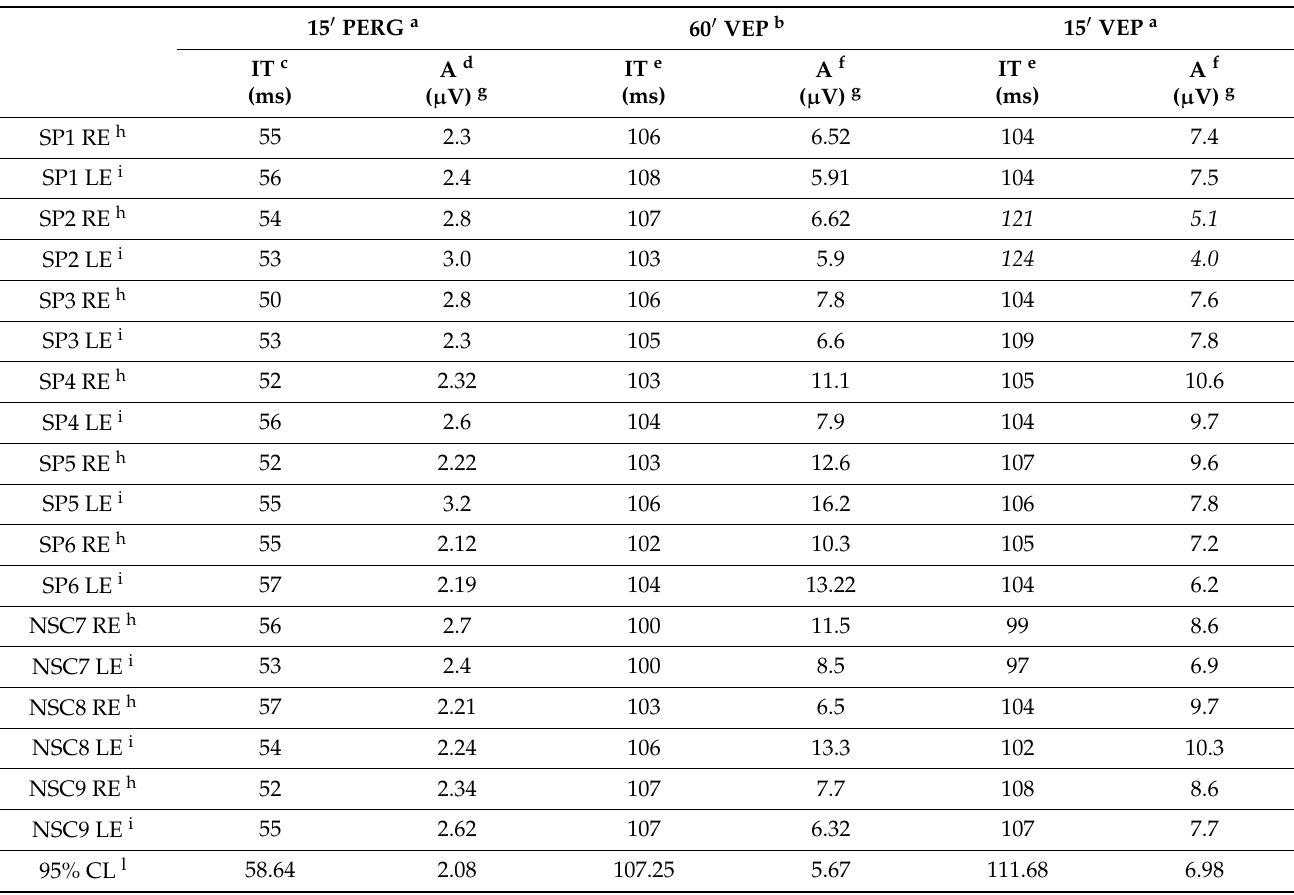
Table 4. Pattern Electroretinogram (PERG) and Visual Evoked Potentials (VEP) data from spinocerebellar ataxia type 1 patients with (SP) and without (NSC) neurological